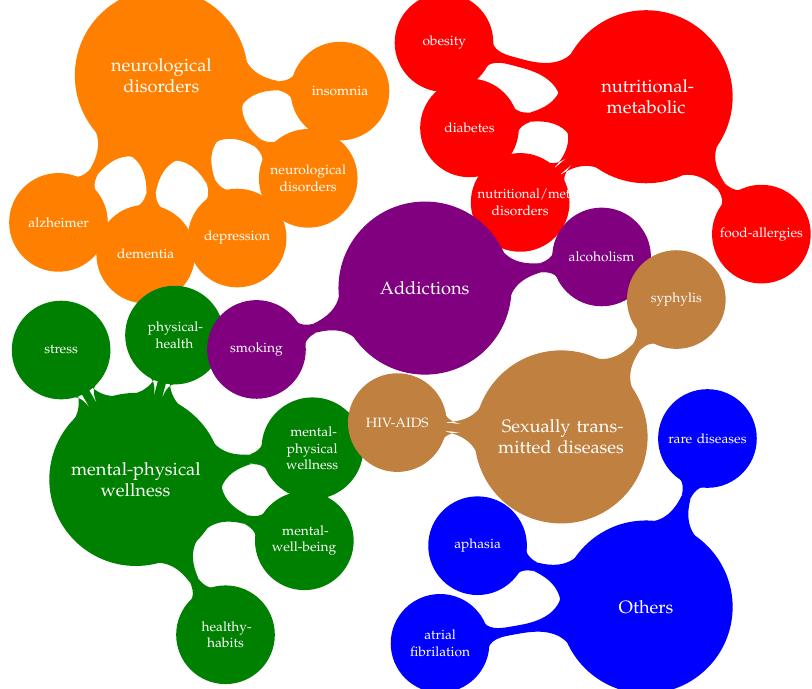
Figure 1. Scheme of illnesses categories that employ chatbots, adapted from the work in